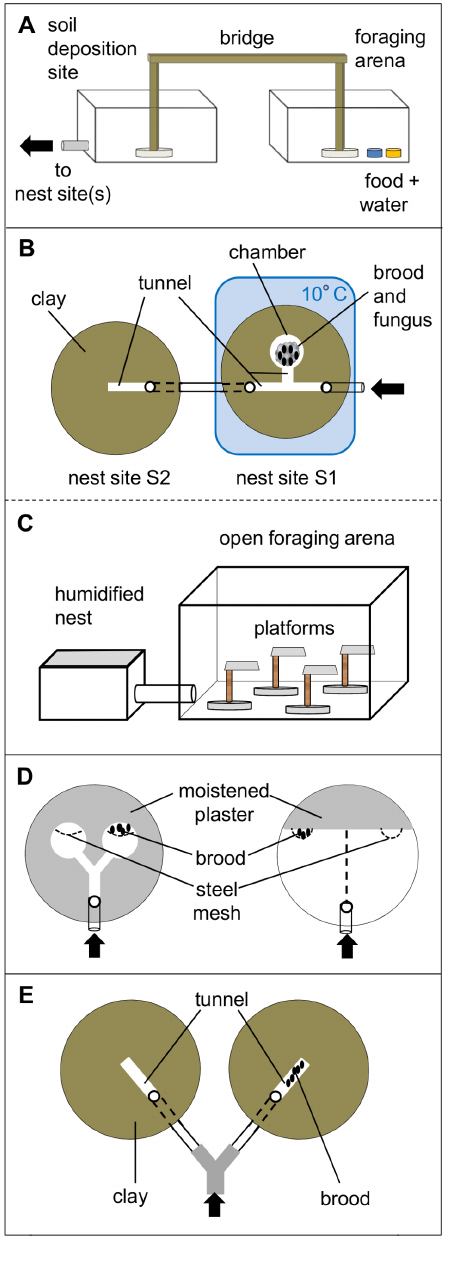
Figure 1. Experimental setups (arrows indicate the direction of entering ants). (a) Foraging area consisting of a soil deposition site (left) and a foraging arena (right). Here the arrow indicates the entry to experimental arena(s). (b) Nest sites for the temperature induced relocation experiment (Experiment 1): left – nest site with cut-out tunnel, at room temperature; right – nest site with cut out tunnels and chamber containing fungus and brood, placed on a cooling plate. (c) Setup for humidity induced relocation experiment (Experiment 2): left – humidified nest with moistened pebbles; right – open foraging arena with 4 experimental platforms. Ants were placed into the foraging arena at the beginning of the experiment. (d) Plaster nest sites for fungus relocation experiment: left – nest site with 2 small chambers, one containing brood (Experiment 3); right – nest site with 1 big chamber, one side containing brood (Experiment 4). (e) Clay nest sites for digging experiments, only one tunnel containing brood (Experi- ments 5 and